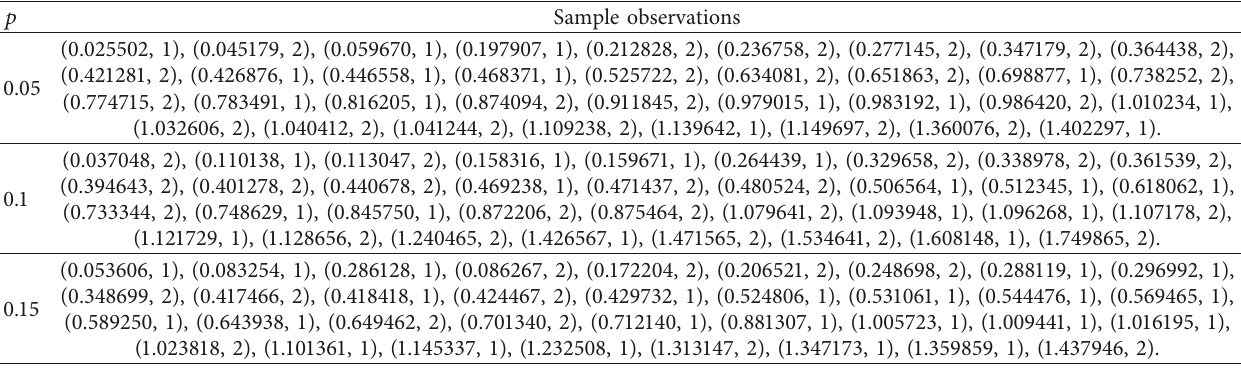
� 1 . 6, θ � 1 . 8, n � 50, and m � 35 for different p � 0 . 05 , 0 . 10 , 0 . 15 { } . ( x, c ) show 1 2